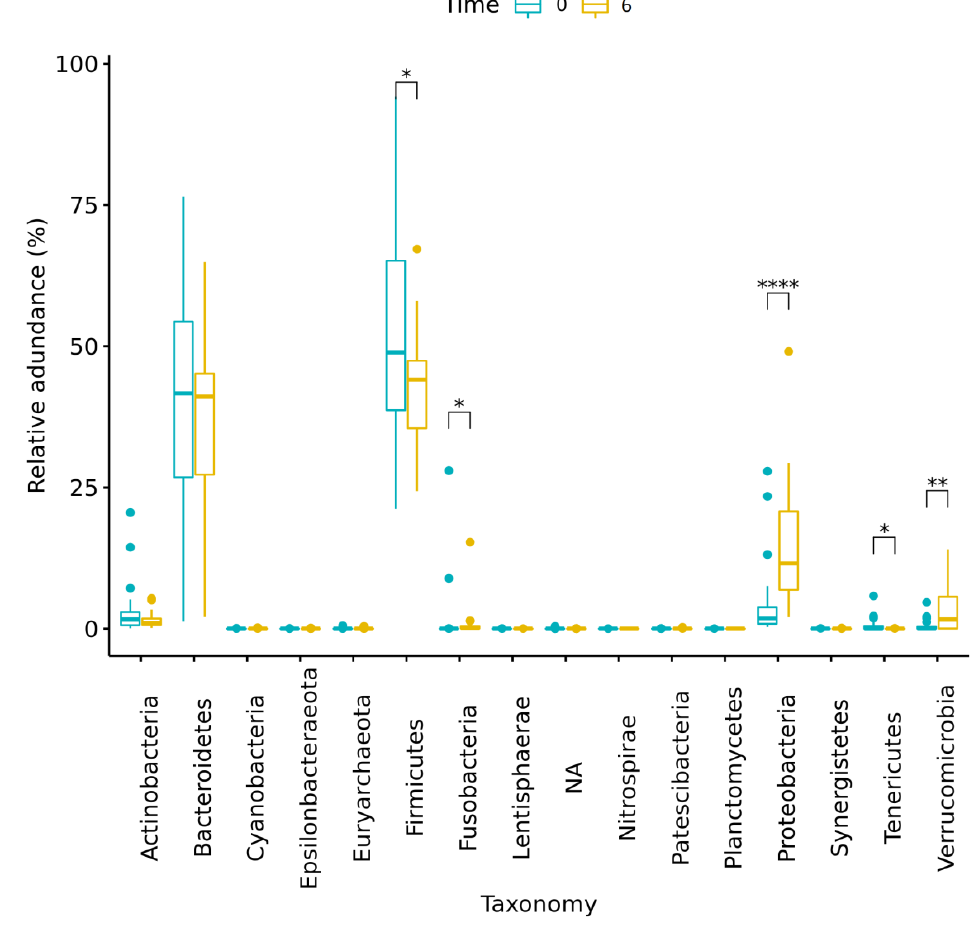
Figure 2. Changes in relative abundances of phyla for all patients ( n = 28) from baseline (Time 0) to 6 months post-surgery (Time 6). Significant differences in abundance are marked with an asterisk (* indicates p < 0.05; ** indicates p < 0.005; **** indicates p < 0.00005). NA = sequences that were assigned to kingdom bacteria but were not assigned to a specific